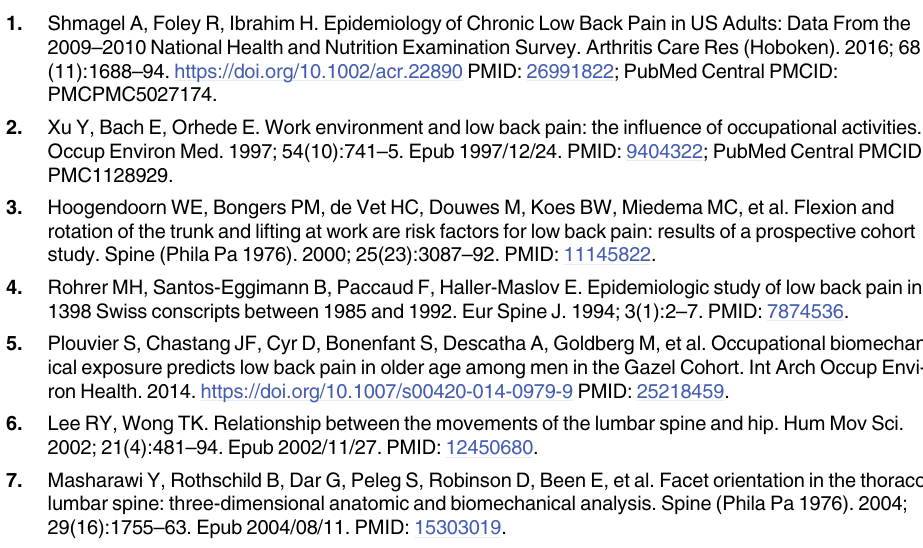
S2 Table. Low back pain questionnaire (Japanese Edition). The subjects who experience low back pain with an intensity greater than 30 mm on the visual analog scale and with duration of > 3 months, kindly answer this questionnaire in